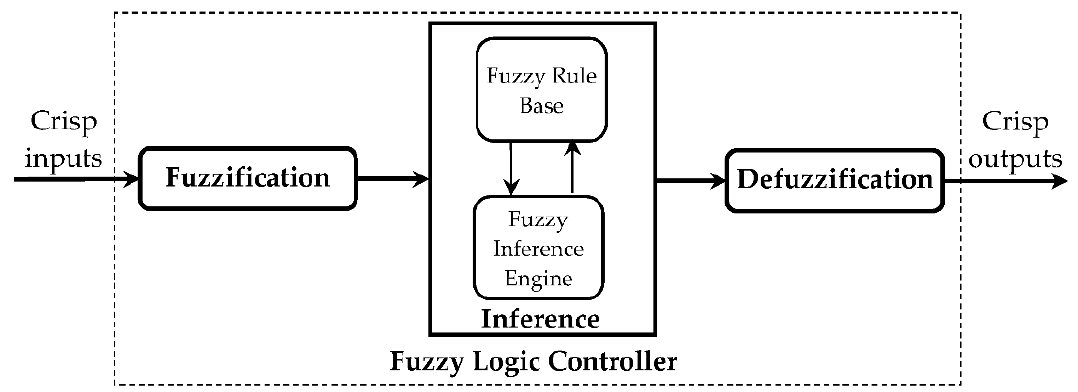
Figure 5. The fuzzy logic controller block diagram.